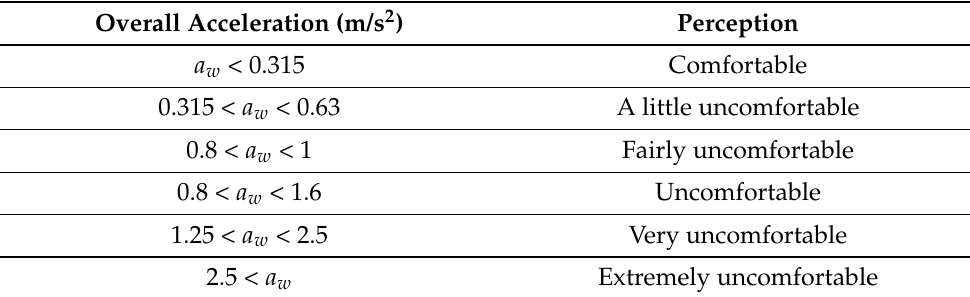
Table 1. Comfort level based on ISO